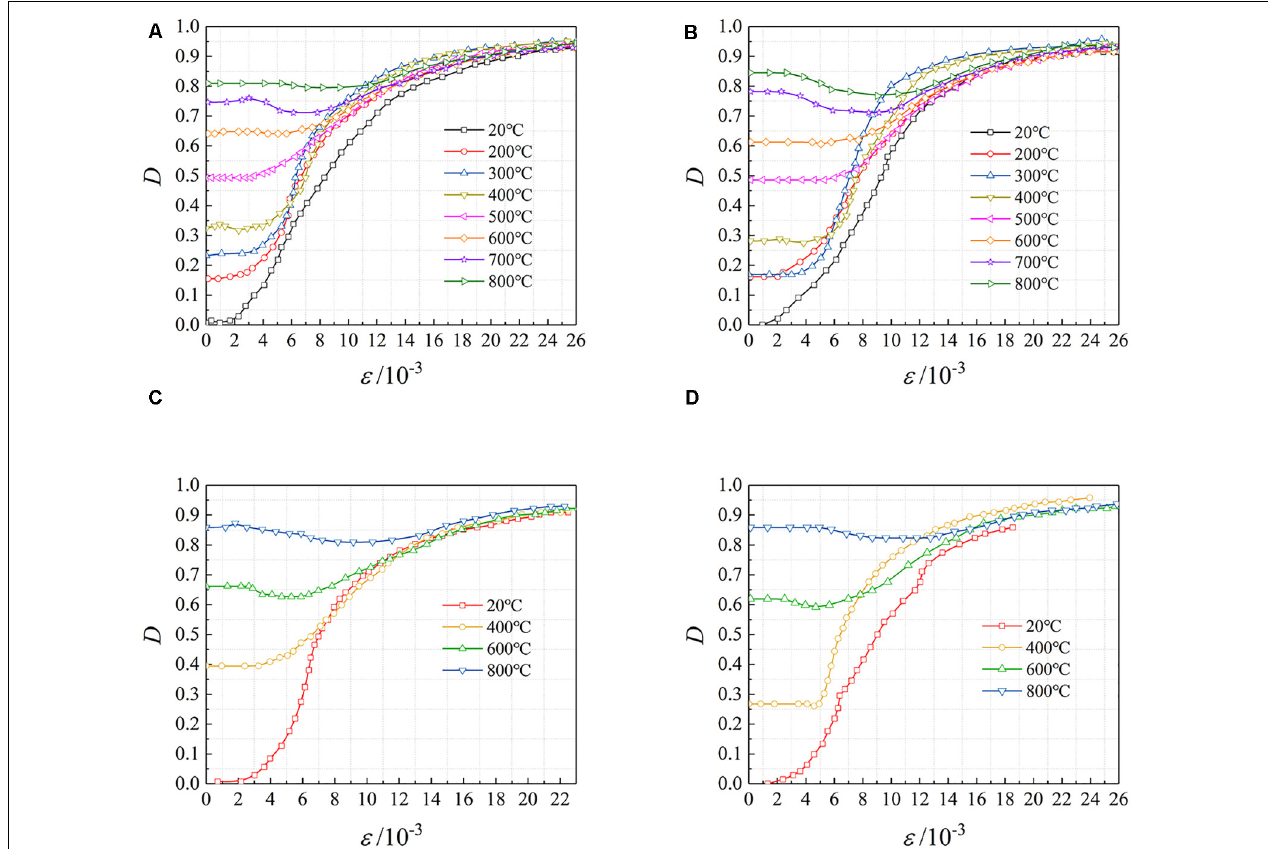
FIGURE 6 | Damage evolutions of specimens after different temperatures. (A) r = 0%, (B) r = 100%, (C) r = 30%, (D) r =